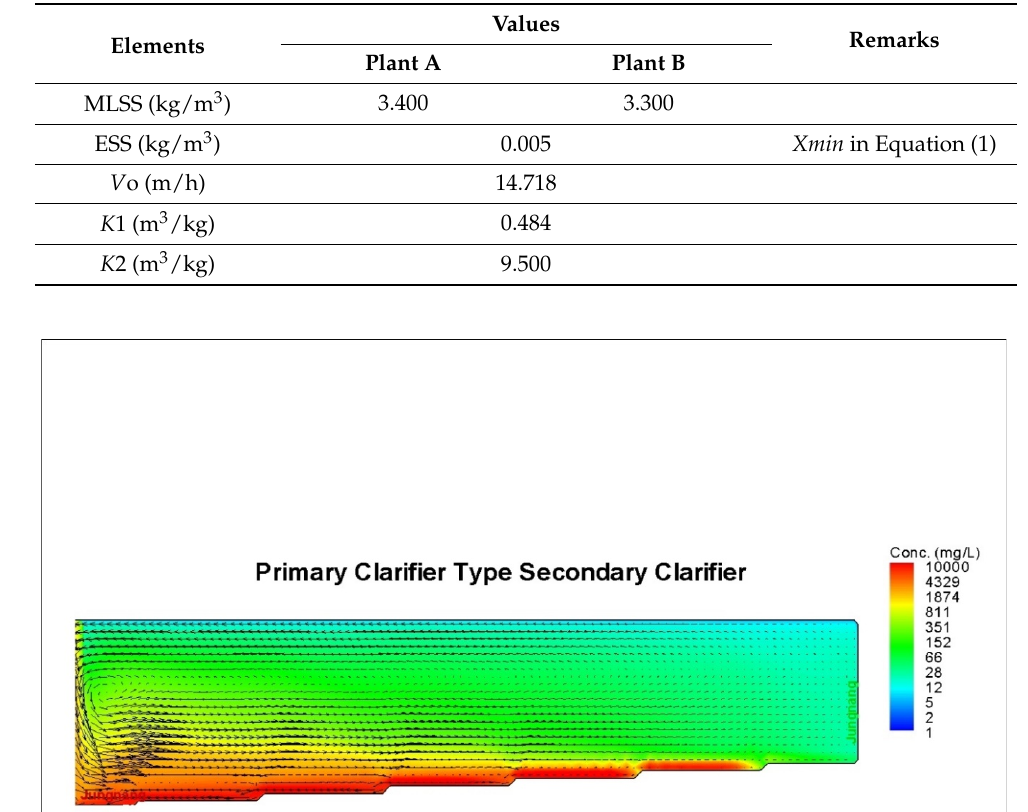
Table 10. Solid settling parameters used in computerized fluid dynamics (CFD) simulation.